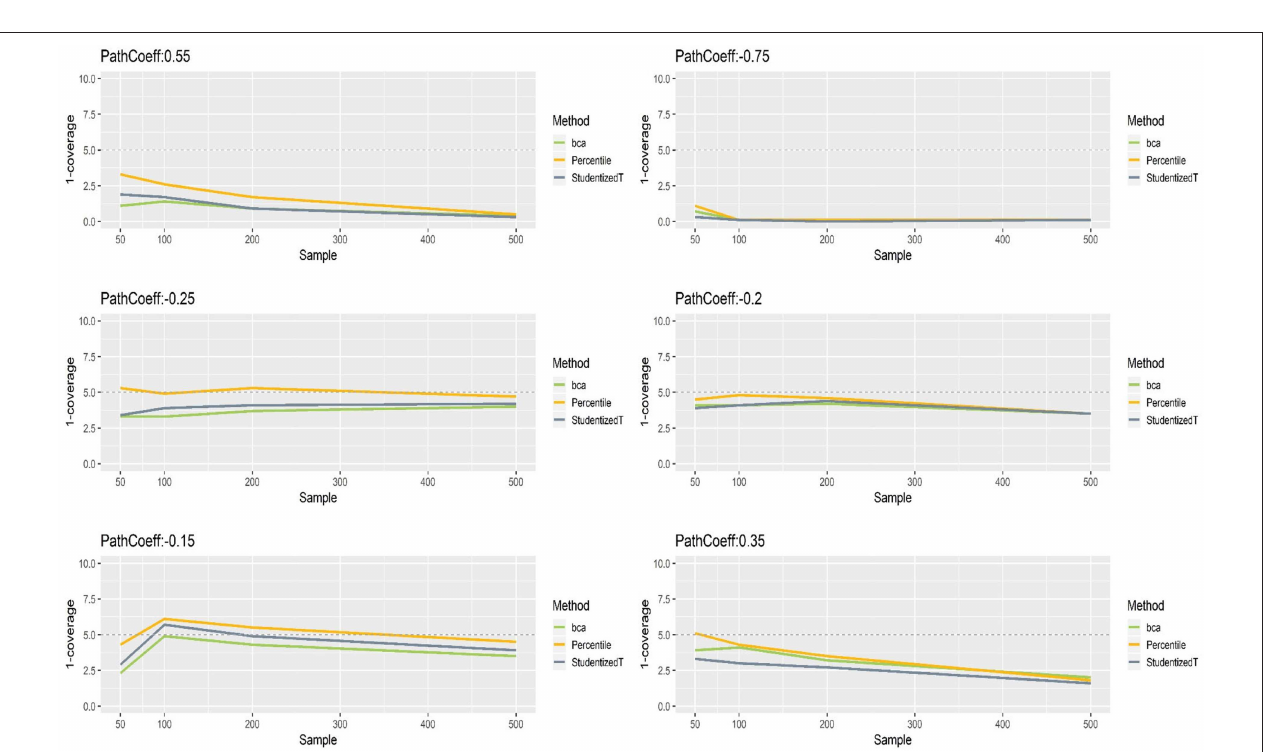
FIGURE 7 | The coverage of percentile, BCa, and Student’s t 95% CIs of path coefficients in the non-normally distributed indicator condition.